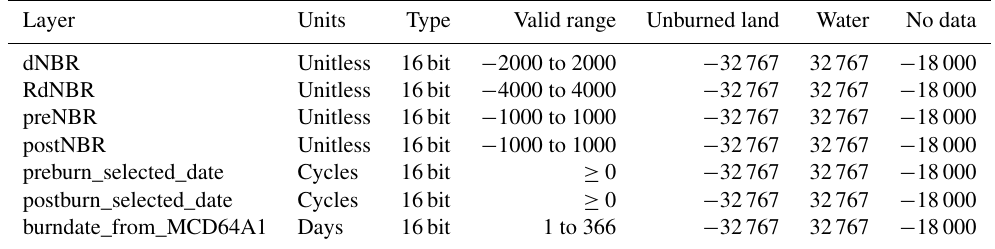
Figure 2. MODIS sinusoidal tiling system and available MOSEV tiles. Table 1. Layers of the MOSEV product. Layer Units Type Valid range Unburned